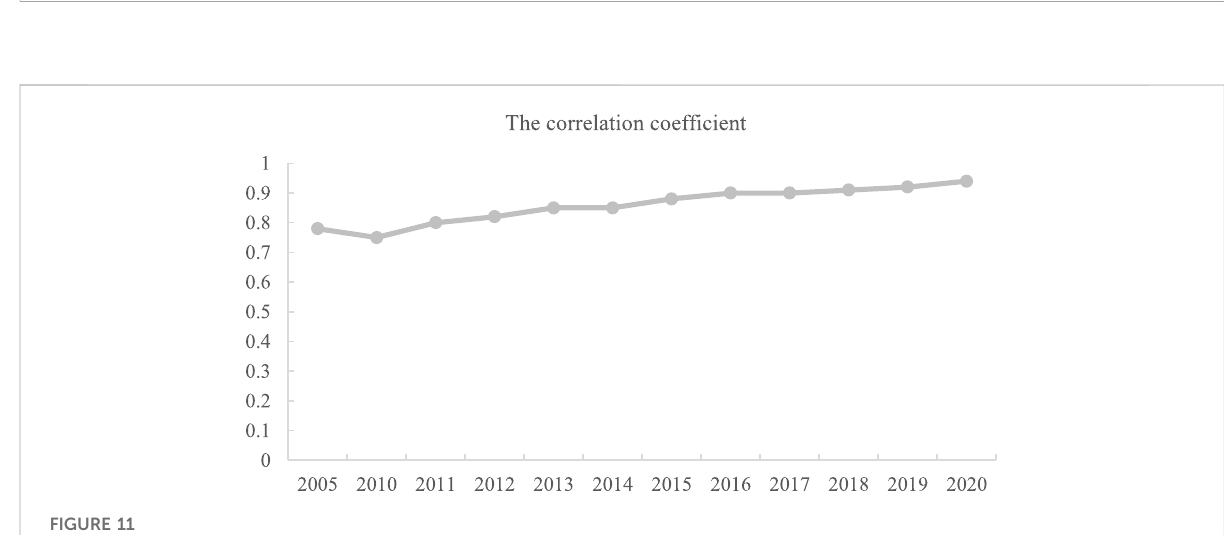
FIGURE 11 Correlation coef fi cient between per capita GDP and the urbanization level in Hubei province, 2005 –